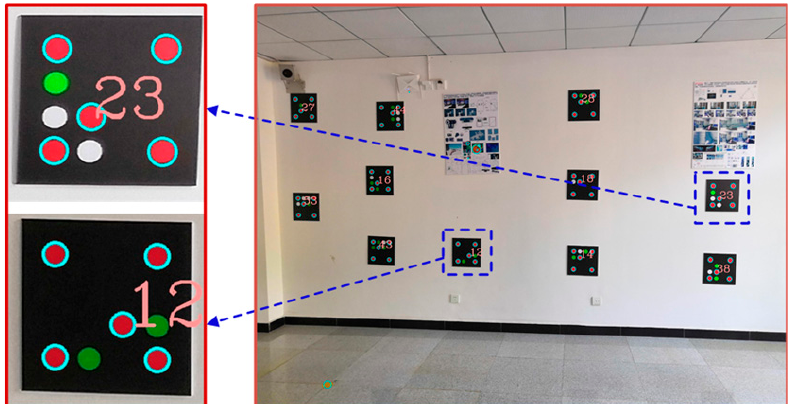
Figure 6. Color-coded mark recognition and decoding.